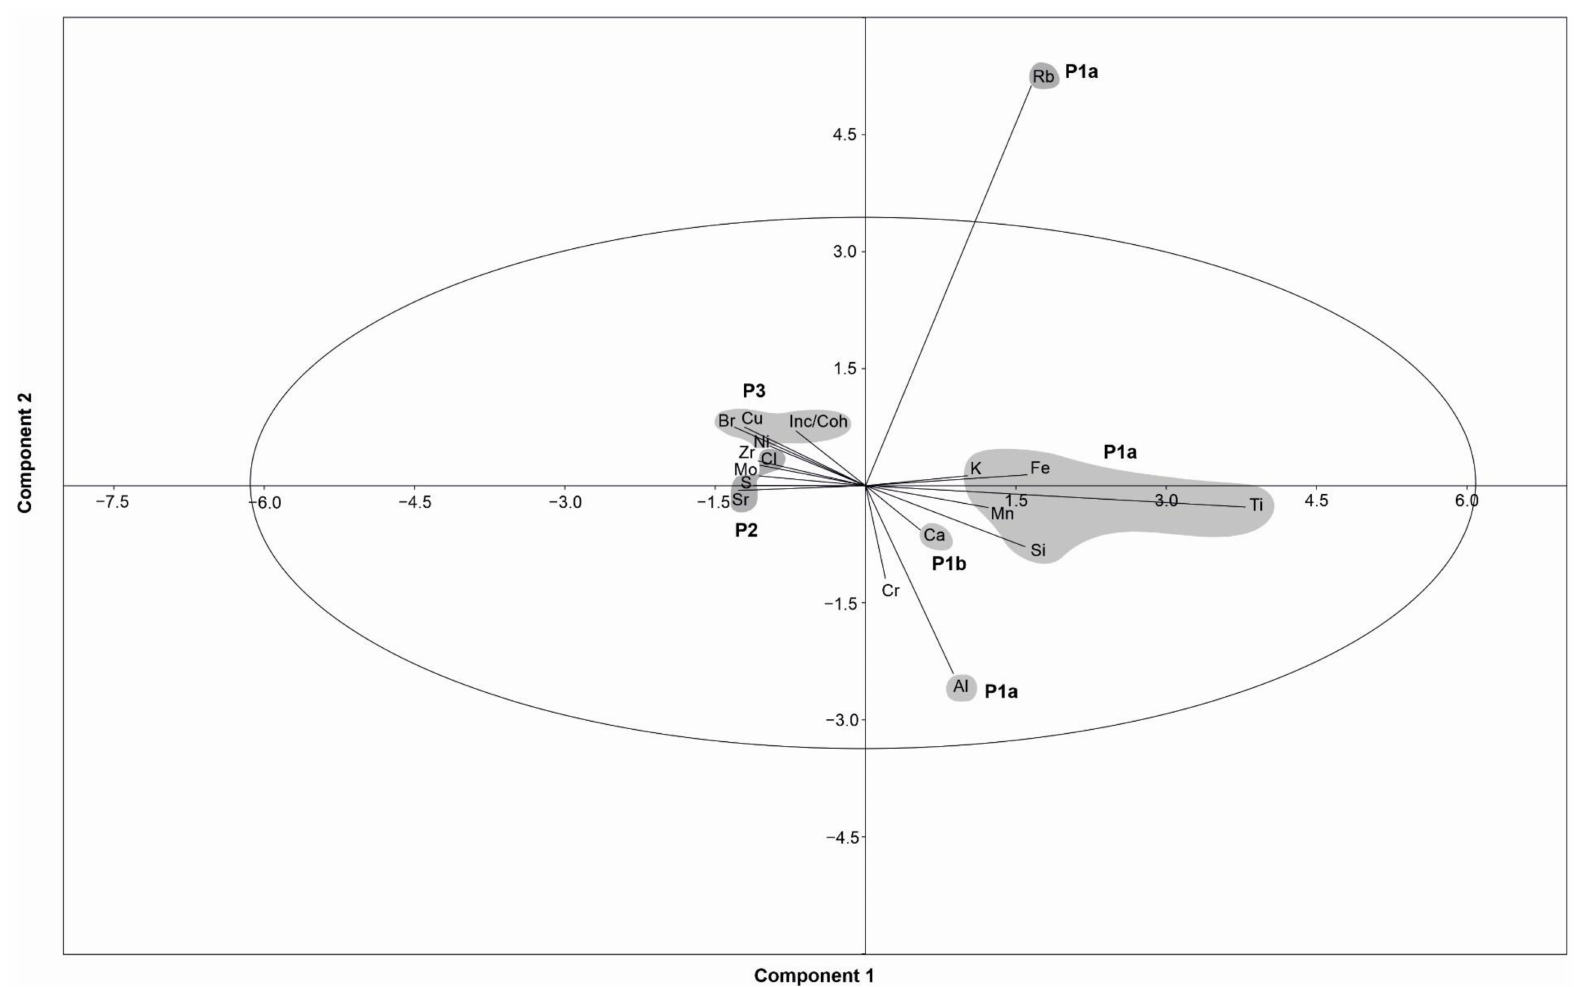
Figure 3. PCA biplot illustrating groupings of the variables associated with the profundal cores (CHI19-1A) from Lake Chiprana. Rb and Al are included in Group P1a but are likely affected by noise causing the observed separation. Ellipse represents the 95% confidence ellipse and shaded areas represent element